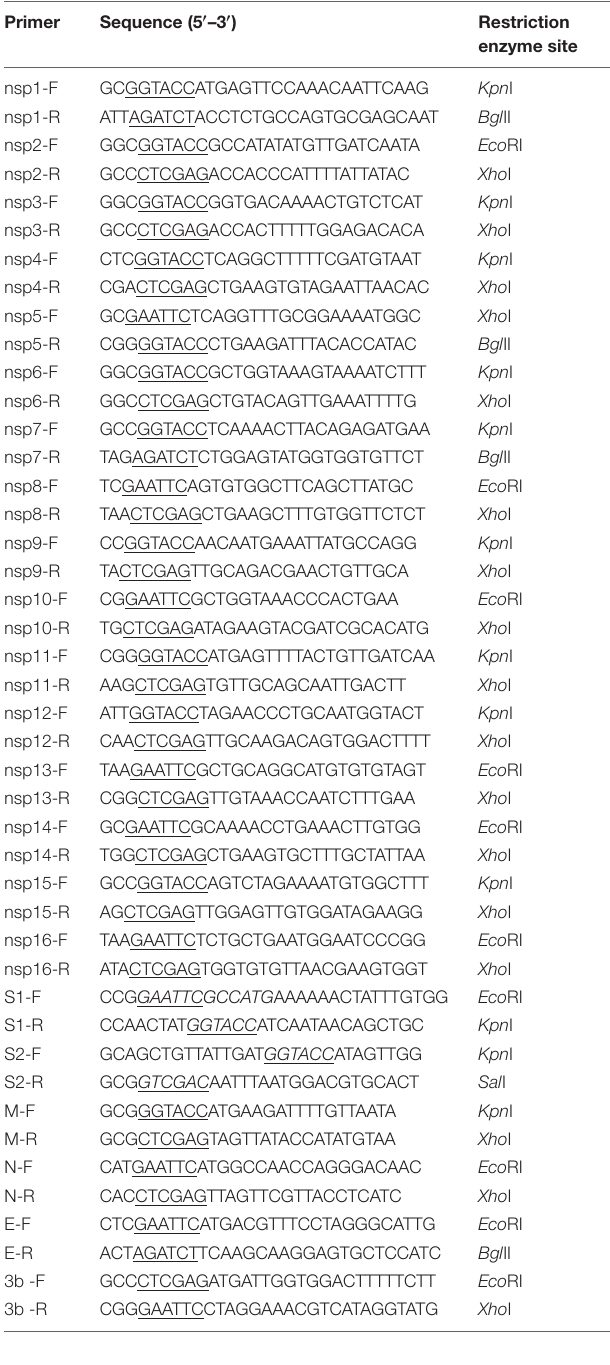
TABLE 1 | Sequences of primers for cloning the TGEV genomic fragments. Primer Sequence (5 (cid:48) –3 (cid:48) )